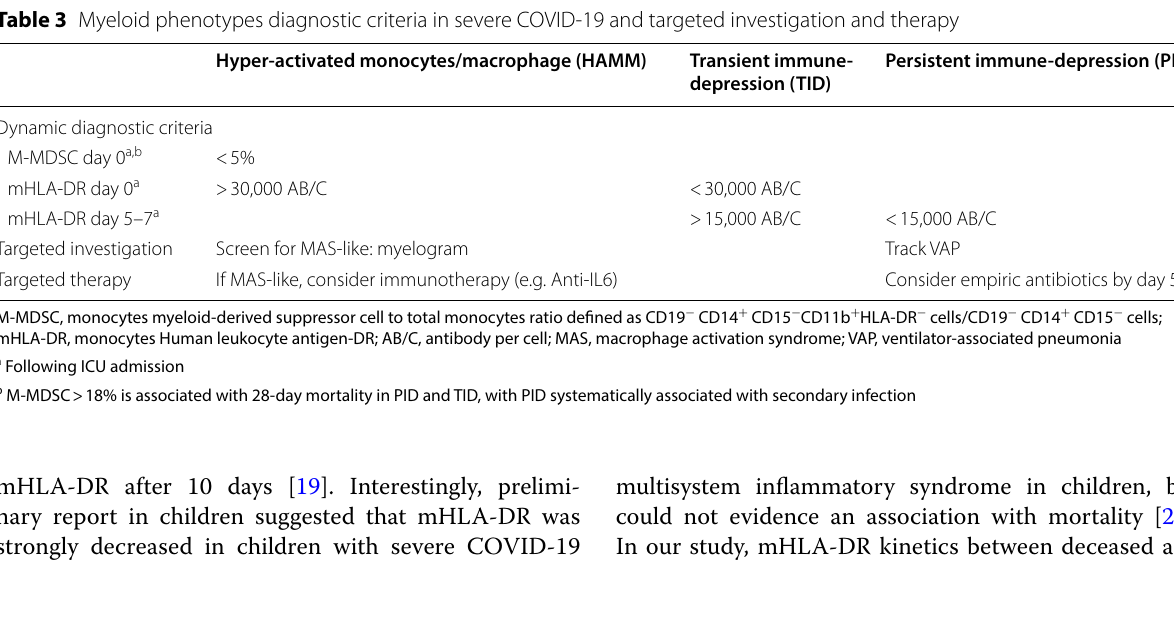
Table 3 Myeloid phenotypes diagnostic criteria in severe COVID‑19 and targeted investigation and therapy